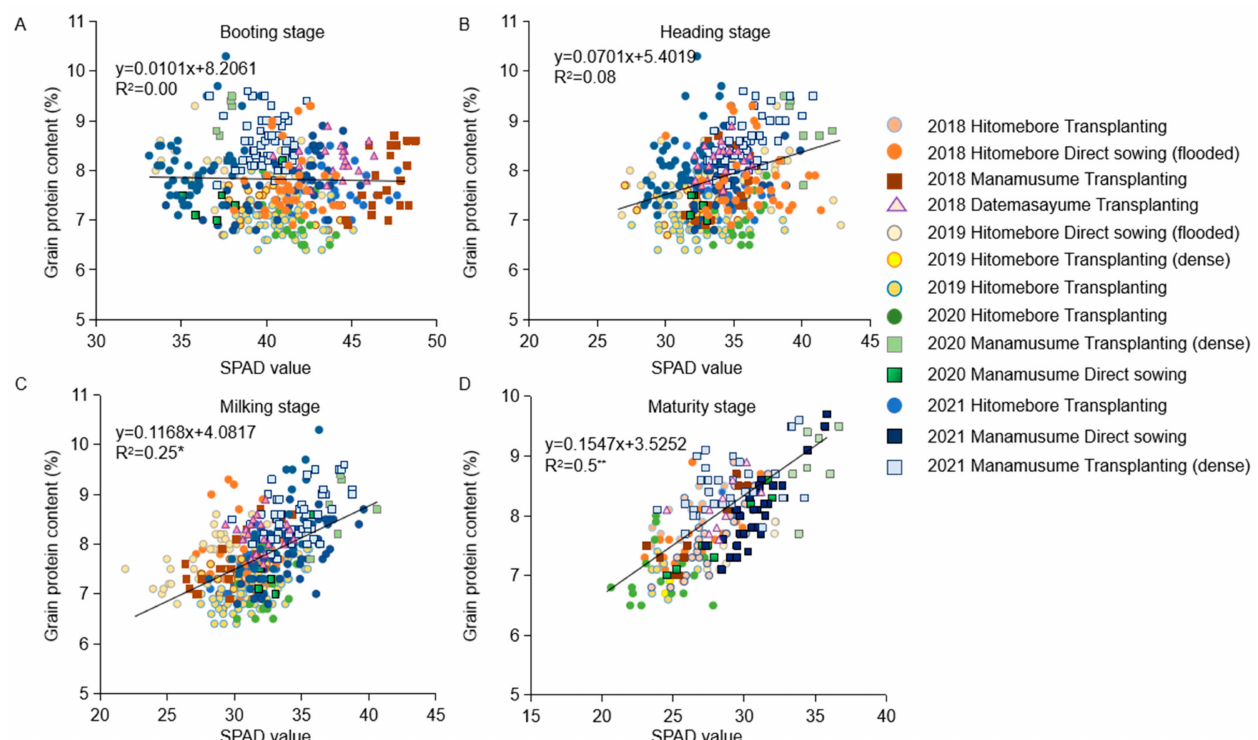
Figure 2. Relationships between grain protein content and SPAD value at different growth stages over four years. *, ** significant at 0.05, 0.01 probability level, respectively.